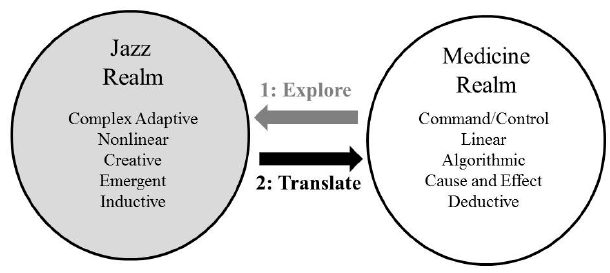
Figure 1. A conceptual model for using jazz to teach communications skills.